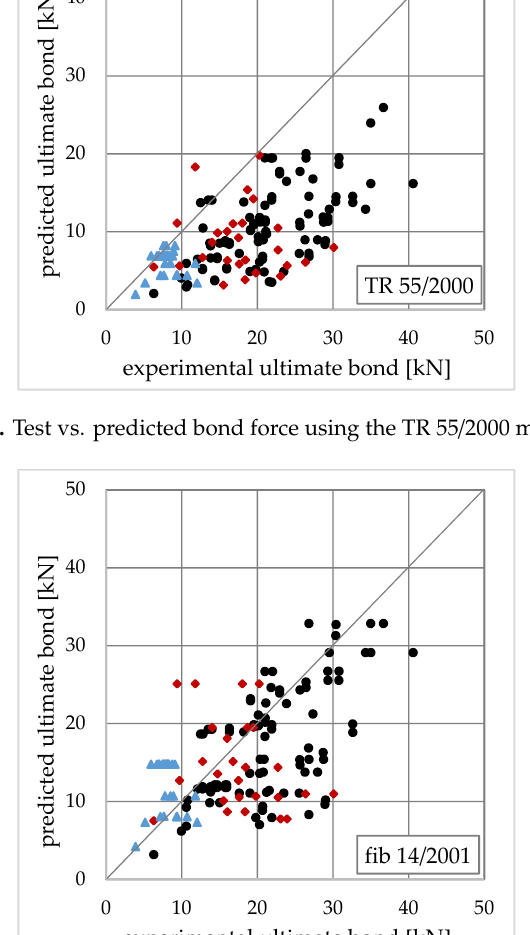
Figure 21. Test vs. predicted bond force using the fib 14/2001 model [34].